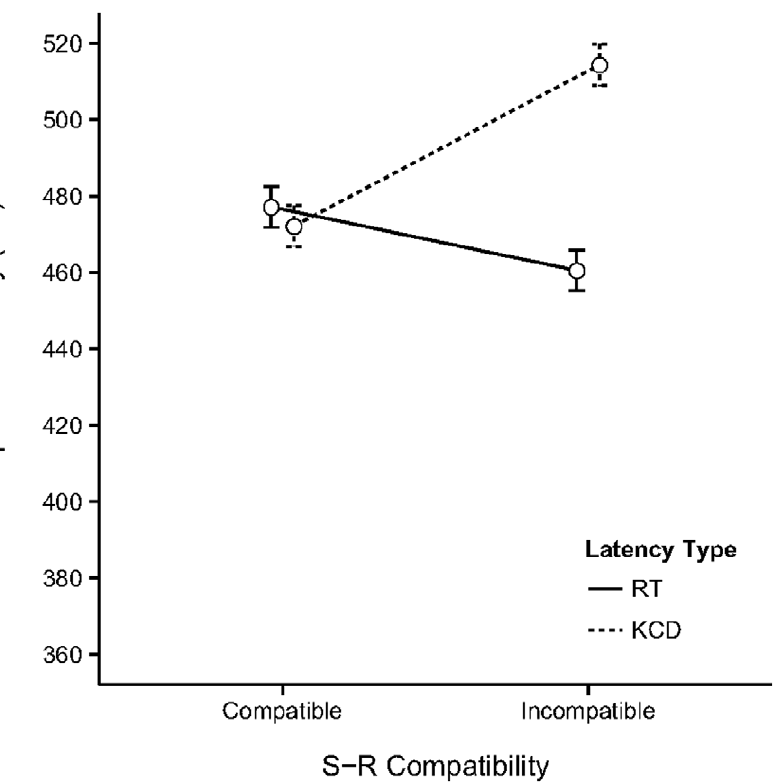
Figure 5. Results of the test phase of Experiments 3A and Experiment 3B in one graph. The observed means (with 95% CI) for the two types of response latency measured in Experiments 3A and 3B as a function of S-R Compatibility of the trials. The values of the means, confidence intervals and size of the Compatibility Effect (CE) are reported in Table S1. Experiment 3A was the key-press only version (RT) and Experiment 3B the key-release only (KCD) version. In these experiments, S-R Compatibility was measured between